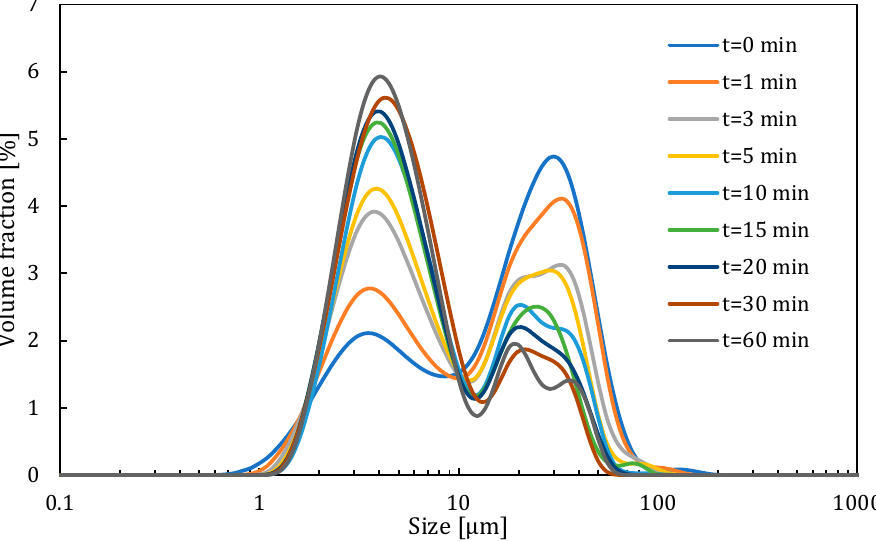
Figure 8. Changes in particle size distributions for deagglomeration using impeller 1, with rotational speed of 1200 rpm. The samples were measured using the LS 13,320 Beckmann Coulter particle size analyzer.